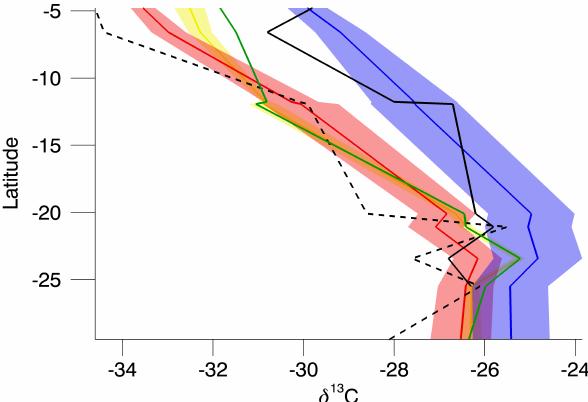
Fig. 2a. (a) Observed and simulated δ 13 C values of leaf-wax n - alkanes at the core sites as a function of latitude. Dashed black line: holocene data; solid black line: LGM data. Simulations: PI (green), MH (yellow), LGM with pre-industrial CO 2 (280ppm, red), and LGM with realistic CO 2 (189ppm, blue).